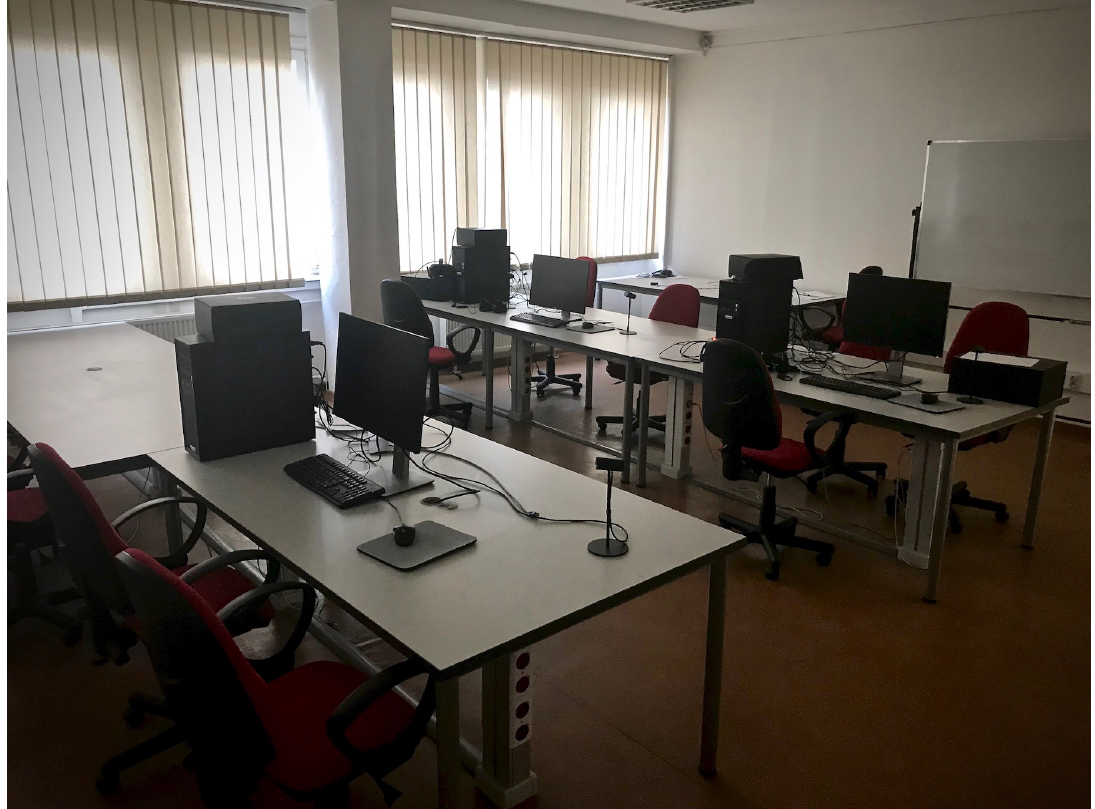
Figure 7. A photograph of the room next to the laboratory where we carried out the test. We show the neighboring room since the actual laboratory is not available at the time of writing this paper. The original laboratory has the same lighting conditions (concordant with Recommendation ITU-T P.913). This picture show very similar